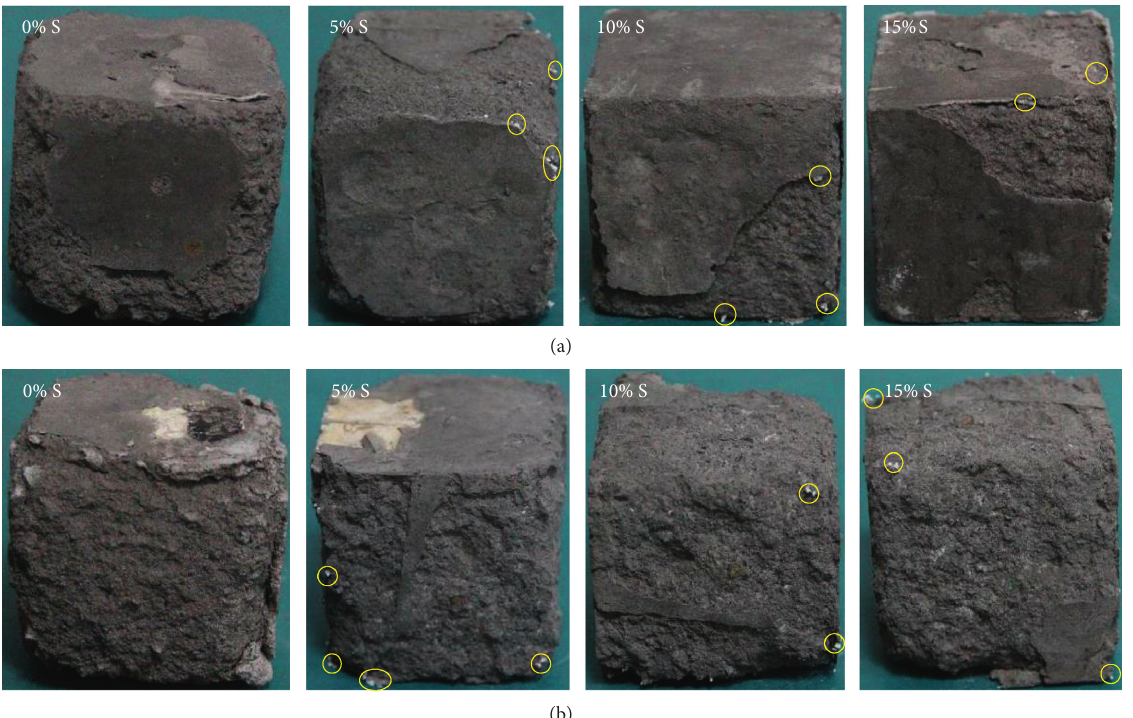
Figure 3: Surface damage of the CGFB samples immersed in 0–15% sodium sulfate solutions at the (a) third and (b) fifteenth drying-wetting cycles.